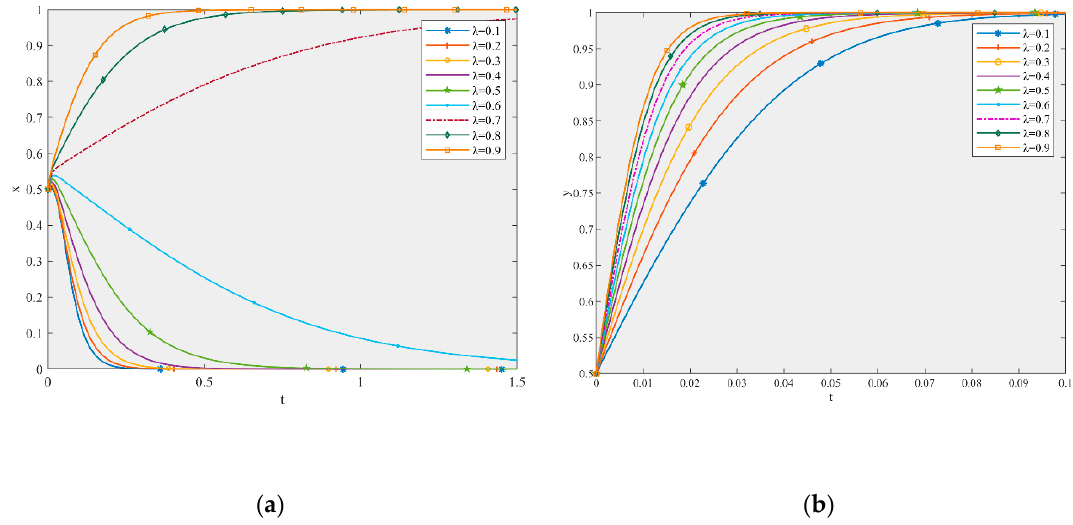
Figure 4. The effect of λ ( a ) on the production unit and ( b ) the recycling unit in the game equilibrium.